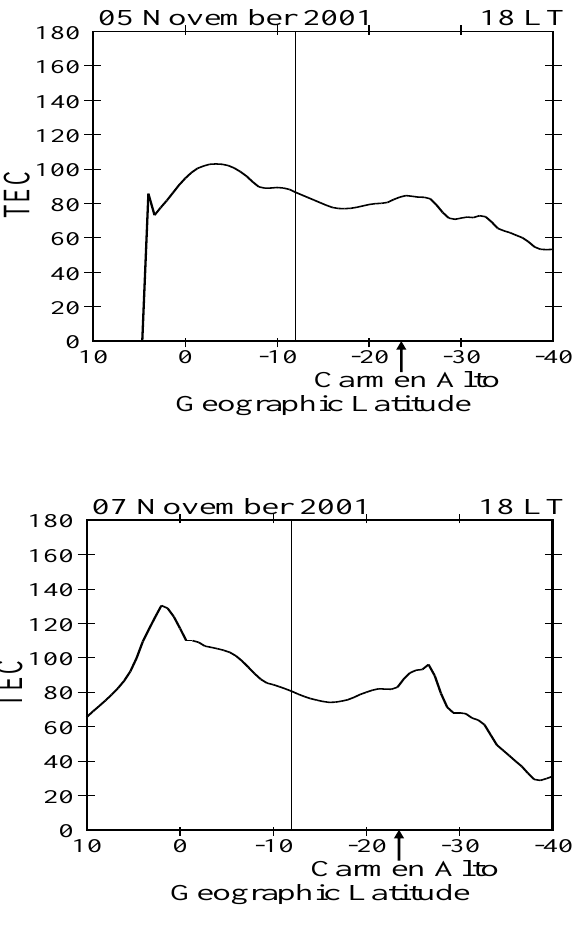
Fig. 9. Total electron content ( × 10 6 electronscm − 2 ) along Ameri- can longitude sector (approximately 70 ◦ W), derived from the GPS phase fluctuations at 18:00 LT for 5 November 2001 (top) and 7 November (bottom). Magnetic equator is shown as a vertical line. Carmen Alto is located at approximately 23.16 ◦ geographic lati- tude, as indicated by an arrow. It can be seen from the latitu- dinal distribution of TEC that the development of the EIA on 5 November was weaker compared with 7 November. Compare the 5 November TEC data with the 2-D plot of dayglow emissions in Fig. 6, where no significant emission enhancements are seen pole- ward of the zenith. On 7 November the latitudinal distribution of TEC shows strong development of the EIA, with a crest poleward of Carmen Alto. Compare this figure with the 2-D plot of the day- glow emissions in Fig. 8, which shows a peak in emissions poleward of zenith on this day. Post-sunset ESF occurred on 7 November and not on 5 November as confirmed by the digisonde data from Jica-